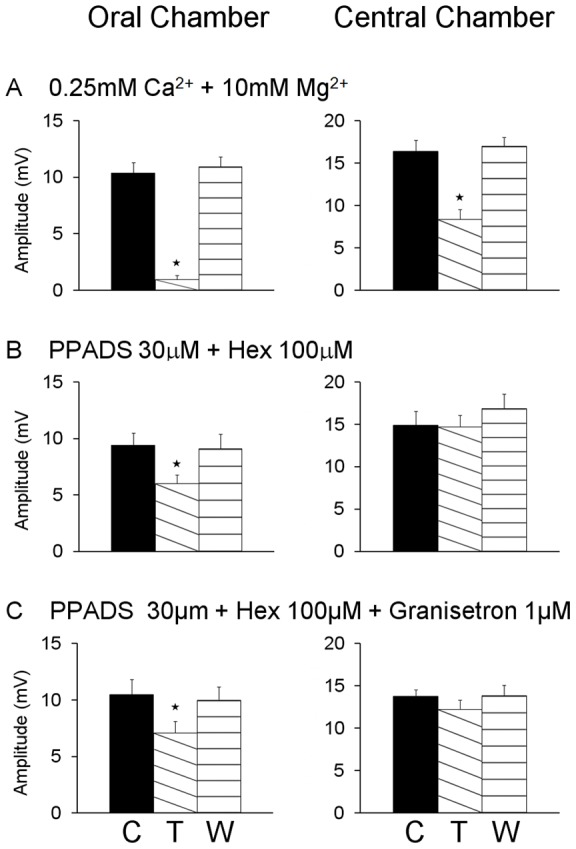
Lack of additional effect of blocking nicotinic acetylcholine receptors and 5-HT3 receptors together with P2 receptors.Top panels show the effects of 30 µM PPADS in the central chamber on reflexes conducted through that chamber (Far chamber distension, left) and reflexes evoked in that chamber (Central chamber distension, right). Data shown in these panels is also shown in Figure 5. Addition of the nicotinic receptor antagonist, hexamethonium (100 µM, second from top panels) or both hexamethonium and the 5-HT3 receptor antagonist, granisetron (1 µM, third from top panels) together with PPADS had no greater effect than PPADS alone. The bottom panels show the effects of complete synaptic blockade in the central chamber for comparison. C – control, D – antagonists present in central chamber, W – after 20 minutes of washout of antagonists.